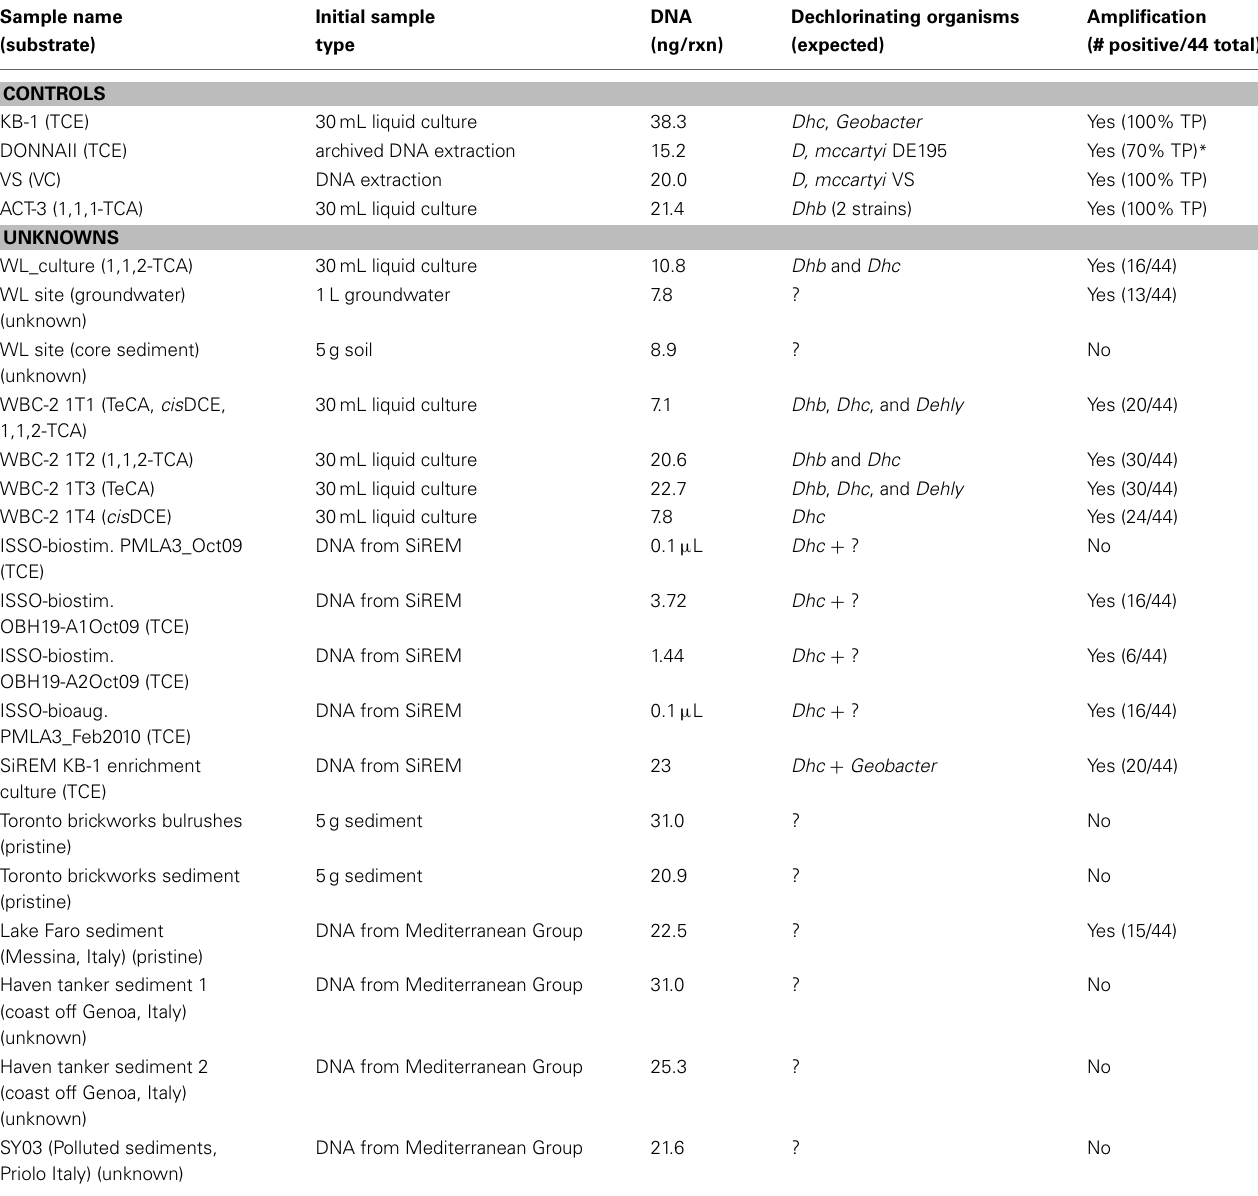
Table 1 | Samples tested with the reductive dehalogenase primer